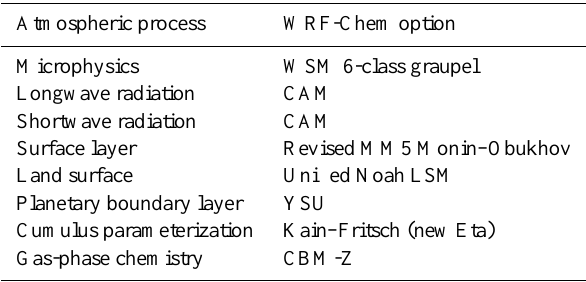
Table A1. Selected WRF-Chem configuration